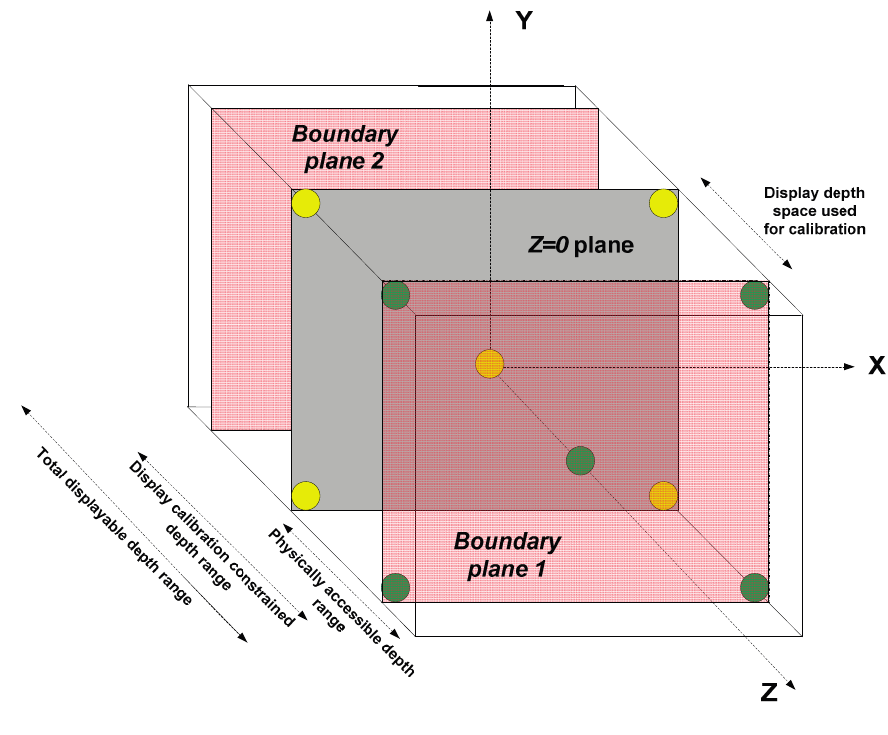
Figure 8. Light field display and Leap Motion Controller calibration: Depth volume bounded by the screen plane and physically accessible constrained boundary plane is calibrated to a comparable sized volume of Leap Motion Controller. Yellow circles show the markers drawn on the screen plane and green circles show markers drawn on boundary plane 1 in the